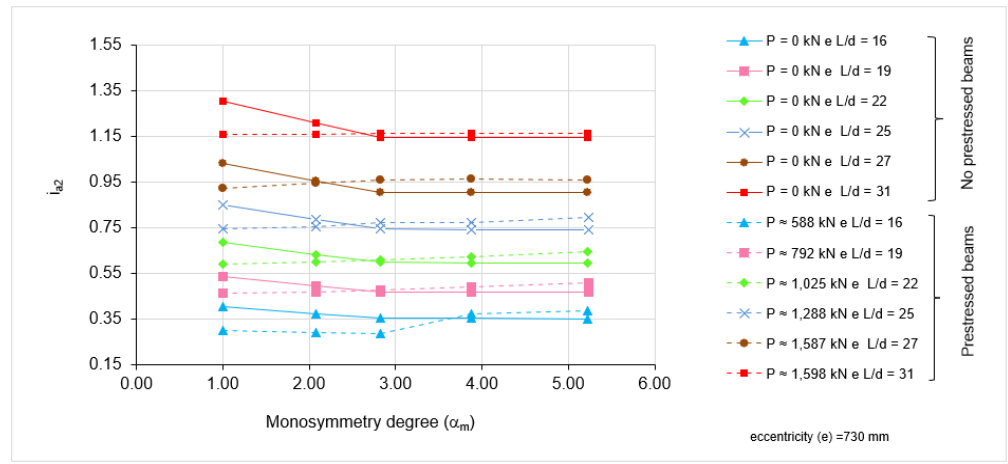
) graph for e p = 730mm. m α